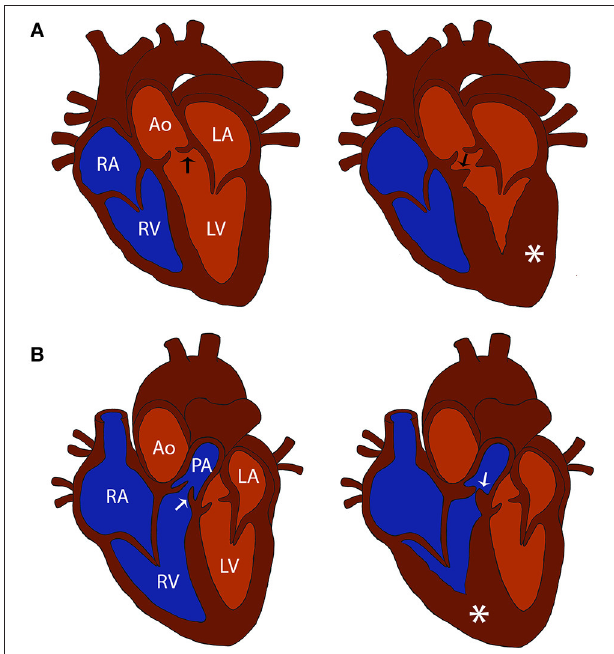
FIGURE 1 | Comparison of normal and cardiac outflow tract abnormalities affected hearts. (A) Diagrams of a normal heart and a heart affected with subvalvular aortic stenosis (SAS). Note the stenosis caused by the subvalvular ridge (arrow) and left ventricular hypertrophy (asterisk) in the SAS affected heart compared to the normal heart. (B) Diagrams of a normal heart and a heart affected with pulmonic stenosis (PS). Note the stenosis caused by thickened pulmonic valve leaflets (arrow) and right ventricular hypertrophy (asterisk) in the PS affected heart compared to the normal heart. Structures in the normal heart diagrams are labeled for reference: RV, right ventricle; RA, right atrium; LV, left ventricle; LA, left atrium; Ao, aorta; PA, pulmonary artery; black arrow, aortic valve; white arrow, pulmonic